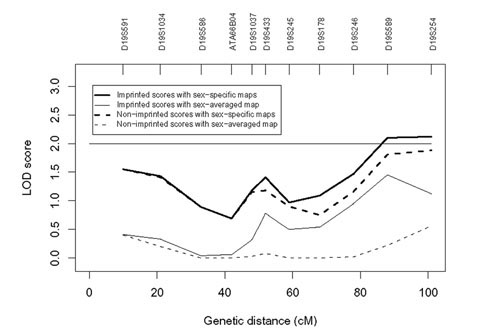
Chromosome 19 LOD scores for sex-specific and sex-averaged maps Map distances on X-axis from the sex-averaged map.